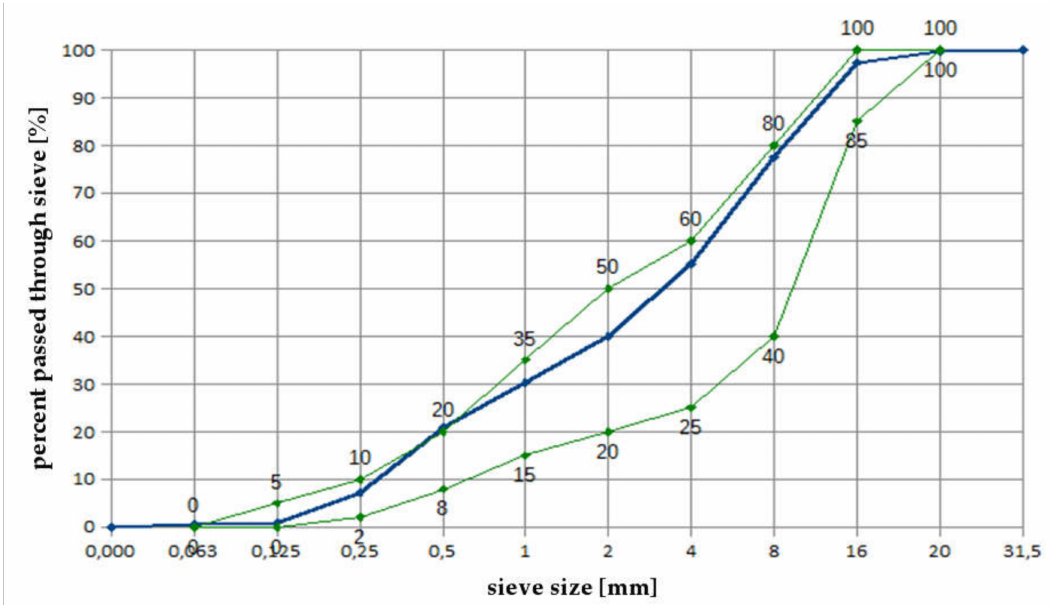
Figure 3. Sieving curves of aggregate mix used for concretes.